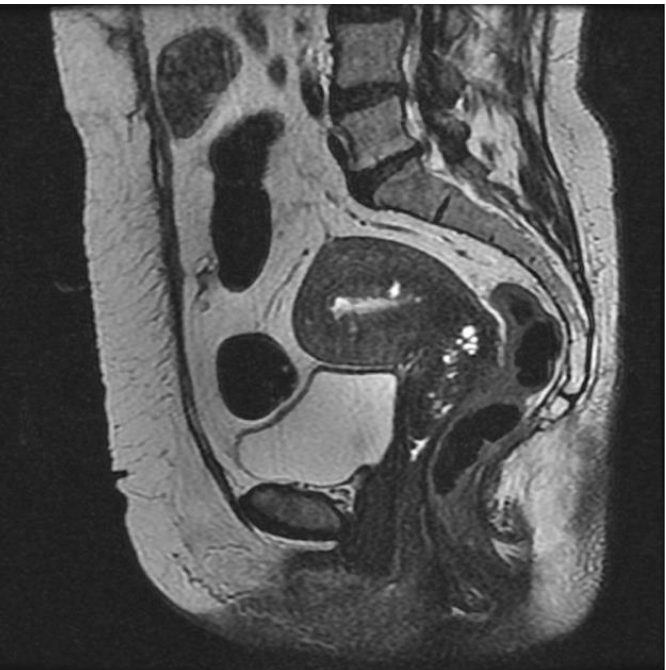
Figure 2. Superficial symmetrical internal adenomyosis: sagittal T2-weighted image representing a disseminated sub-endometrial tiny cyst without JZ hypertrophy in both anterior and posterior uterine wall.